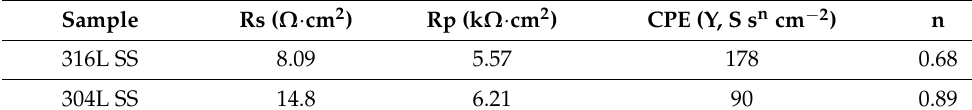
Table 3. EIS data of the 316L SS and the 304L SS in 3.5% NaCl solution.